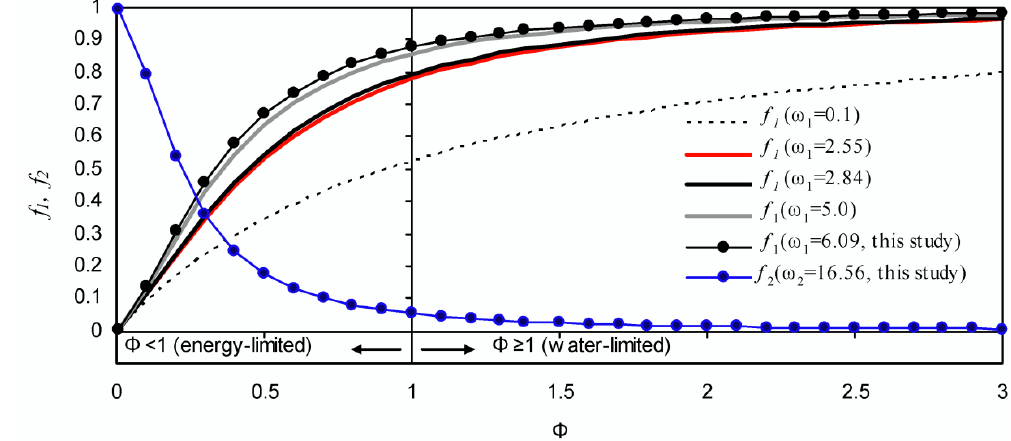
Figure 4. Variation of f 1 (Equation 3c) and f 2 (Equation 8b) values versus Φ using the ω 1 and ω 2 of